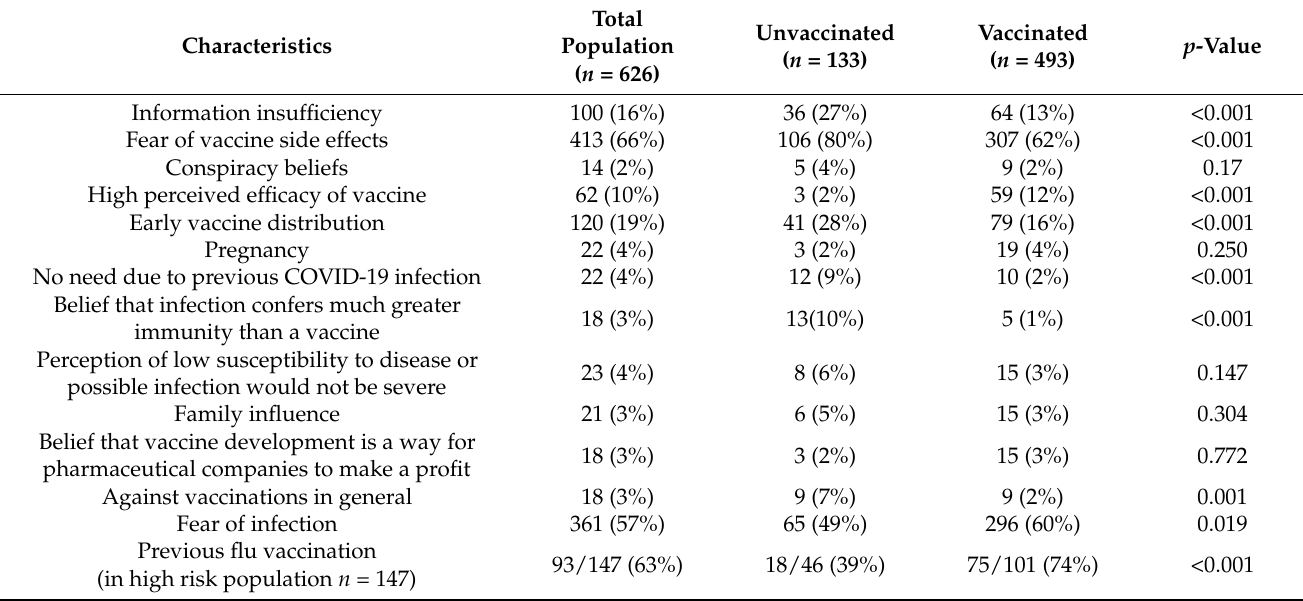
Table 4. Reported knowledge, attitudes and beliefs about COVID-19 for vaccinated and for unvaccinated